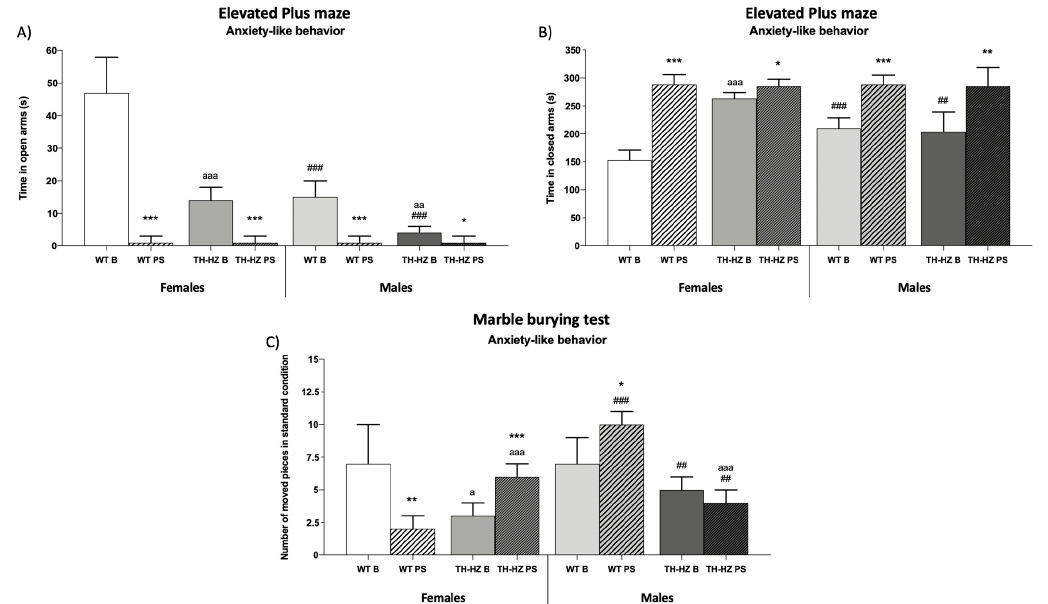
Figure 2. Anxiety-like behaviors. ( A ) Time (in seconds) in open arms of elevated plus maze (EPM). ( B ) Time (in seconds) in closed arms of EPM. ( C ) Number of pieces moved in the marble burying test. Each column represents the mean ± standard deviation of values corresponding to 6 animals. * p < 0.05, ** p < 0.01, *** p < 0.001 compared to basal condition, a p < 0.05, aa p < 0.01, aaa p < 0.001 compared to WT. ## p < 0.01, ### p < 0.001 compared to female. WT B: Wild type basal. WT PS: Wild type post-stress. TH-HZ B: TH-HZ basal. TH-HZ PS: TH-HZ post-stress.